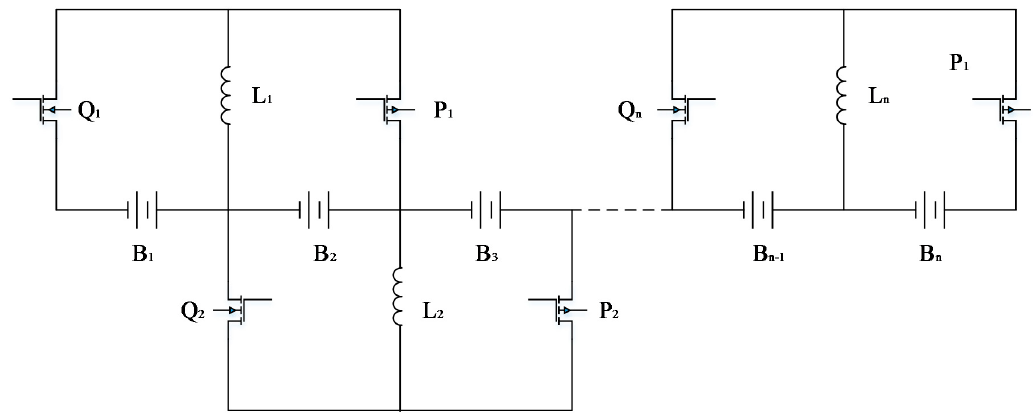
Figure 3. Balance principle of inductors in adjacent cells.